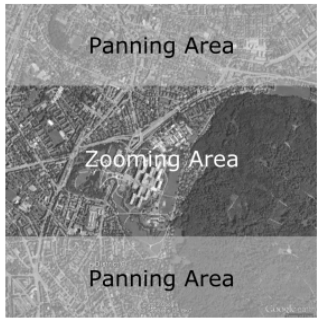
Figure 2. Surfing concept: Geographic visualization with panning